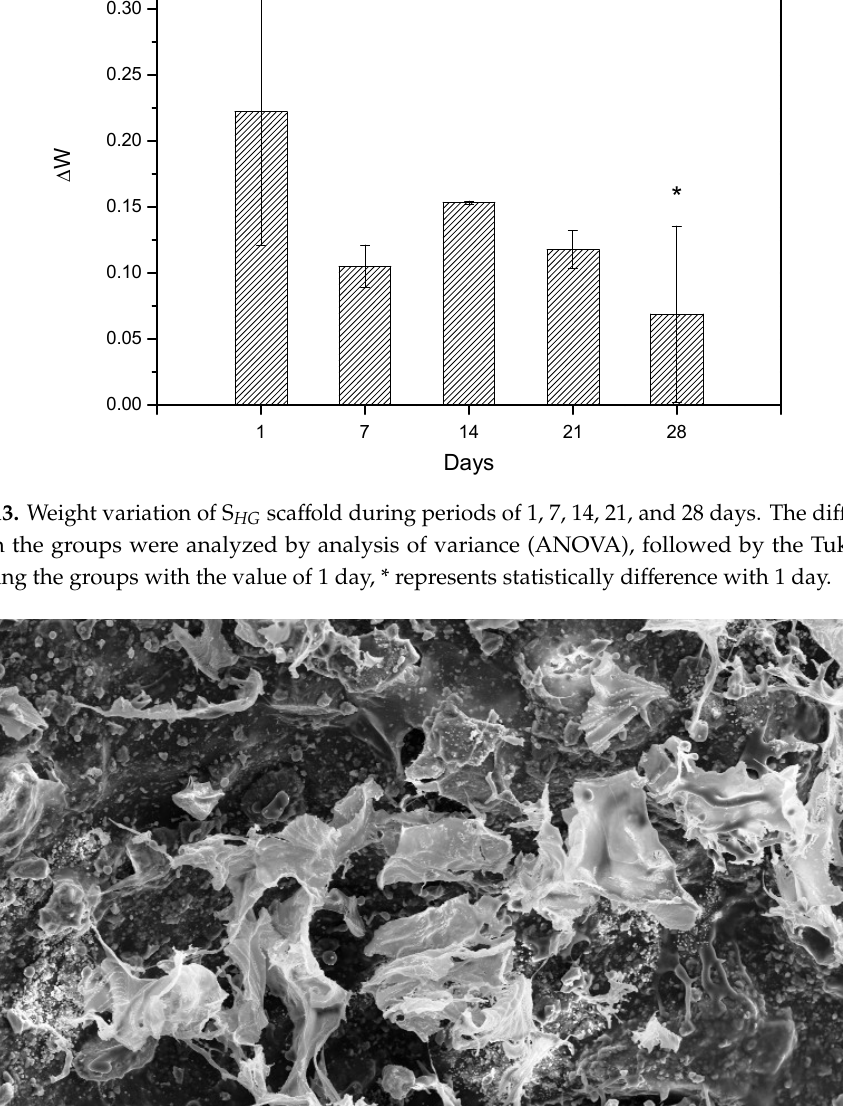
Figure 14. S HG SEM (Scanning Eetronic Microscopy) after 7 days immersion in PBS buffer.